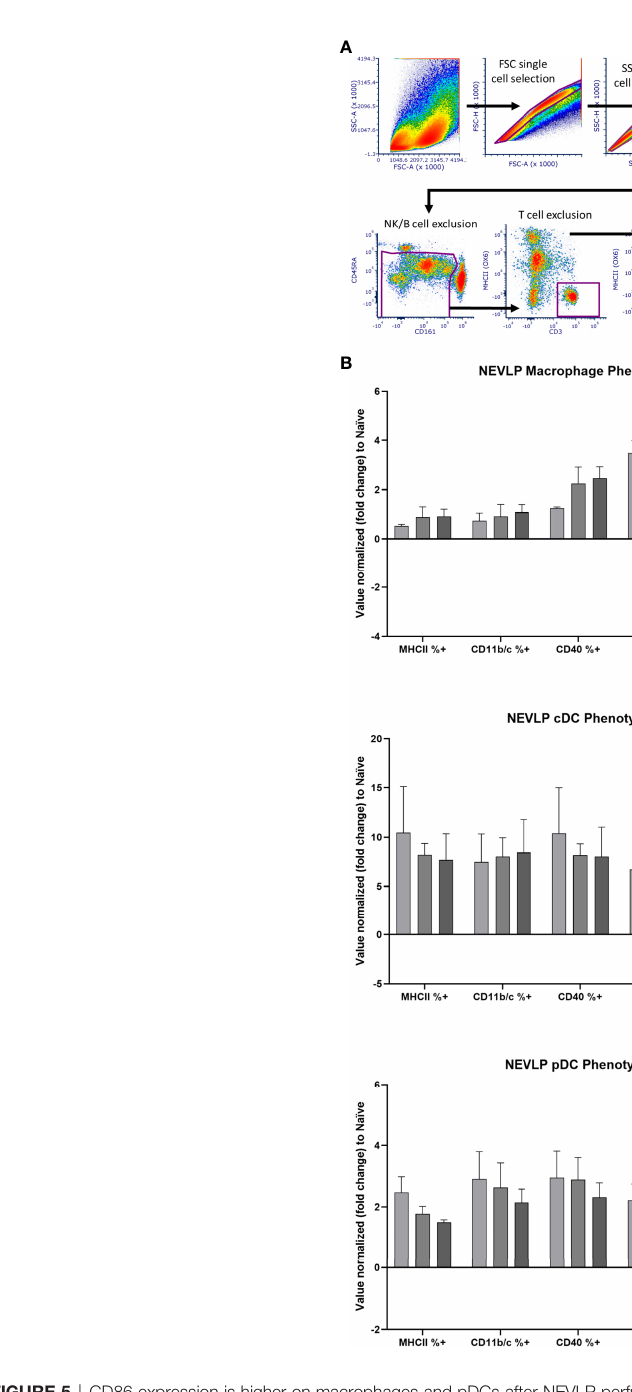
FIGURE 5 | CD86 expression is higher on macrophages and pDCs after NEVLP perfused with human pRBCs. (A) Liver-resident immune cells were identi fi ed in the NPC compartment using the following gating strategy: after single cells and live cells were identi fi ed, immune cell identi fi cation with CD45, T-cell and B-cell exclusion using CD3 and CD45RA, and NK cell exclusion of CD161hi/MHC II- cells were done. cDCs (CD45+, CD103+, CD11bc+), pDCs (CD45+, CD4+, MHCII+, CD103-, CD11bc-), and macrophages (CD45+, CD4+, MHCII+, CD103lo, CD11bc+) were then identi fi ed as shown. (B) Populations were gated into positive vs. negative phenotypes when appropriate. Median fl uorescence intensity (MFI) was used for signals showing variability on a gradient. Data consist of naive (n = 4), SCS (n = 4), NEVLP with human pRBC (n = 6), NEVLP with rat pRBC (n = 5), and NEVLP with Oxyglobin (n = 7). *p< 0.05, **p <